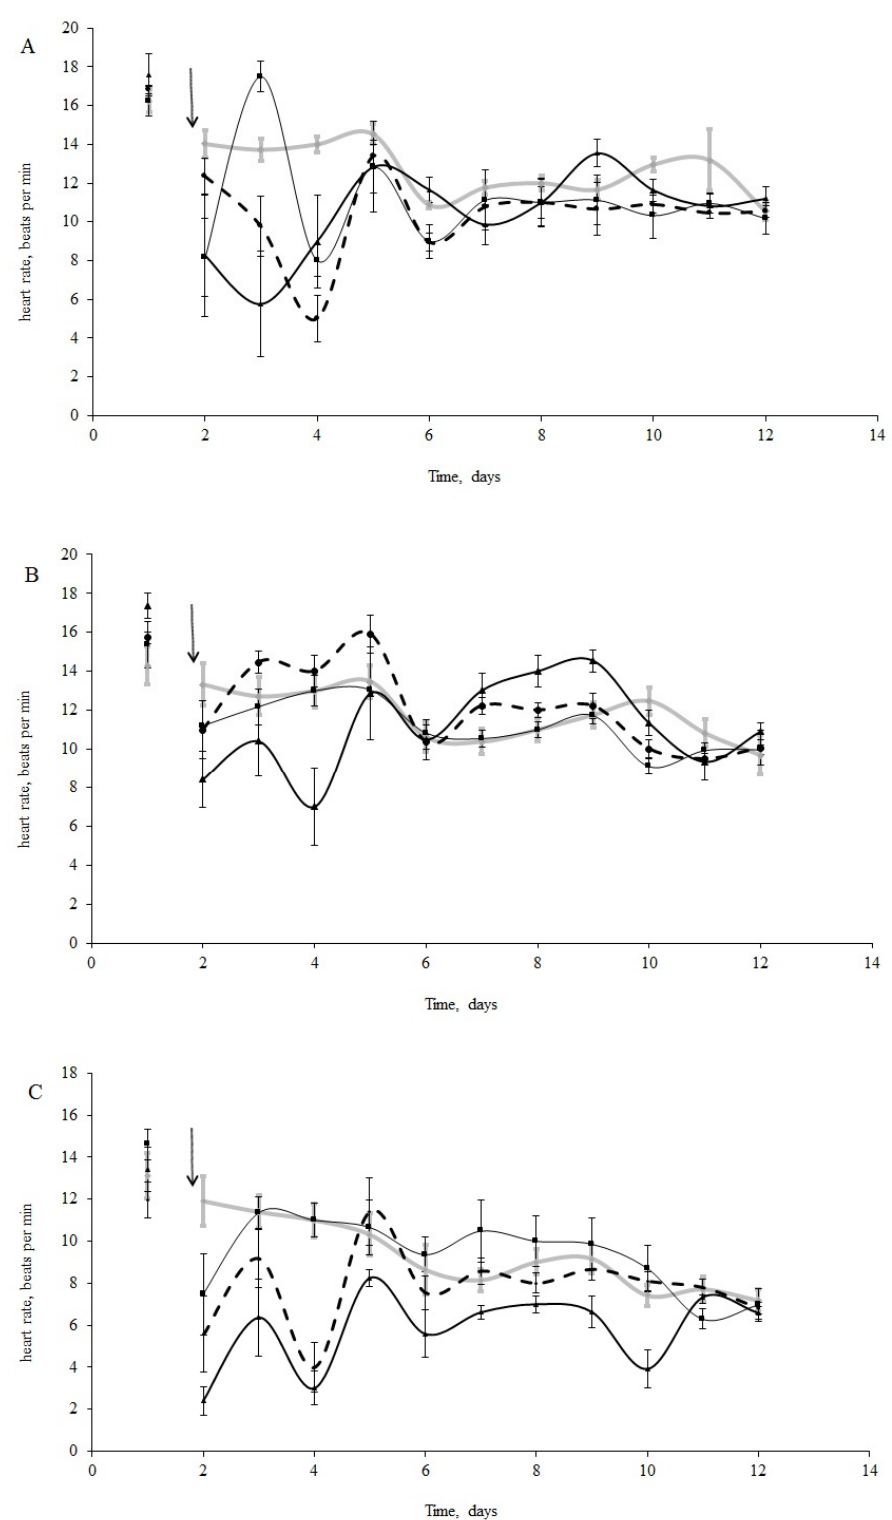
Figure 2. ( A ) Heart rate change in blue mussels under 25 psu salinity; ( B ) Heart rate change in blue mussels under 15 psu; ( C ) Heart rate change in horse mussels under 25 psu salinity (with no oil (grey line) and under exposure to low (L), medium (M), and high (H) crude oil concentrations: thin black line, thick black line, and dotted black line, respectively; the arrow points to the time of pollution water added). Each point represents the mean of seven individuals; error bars are a standard